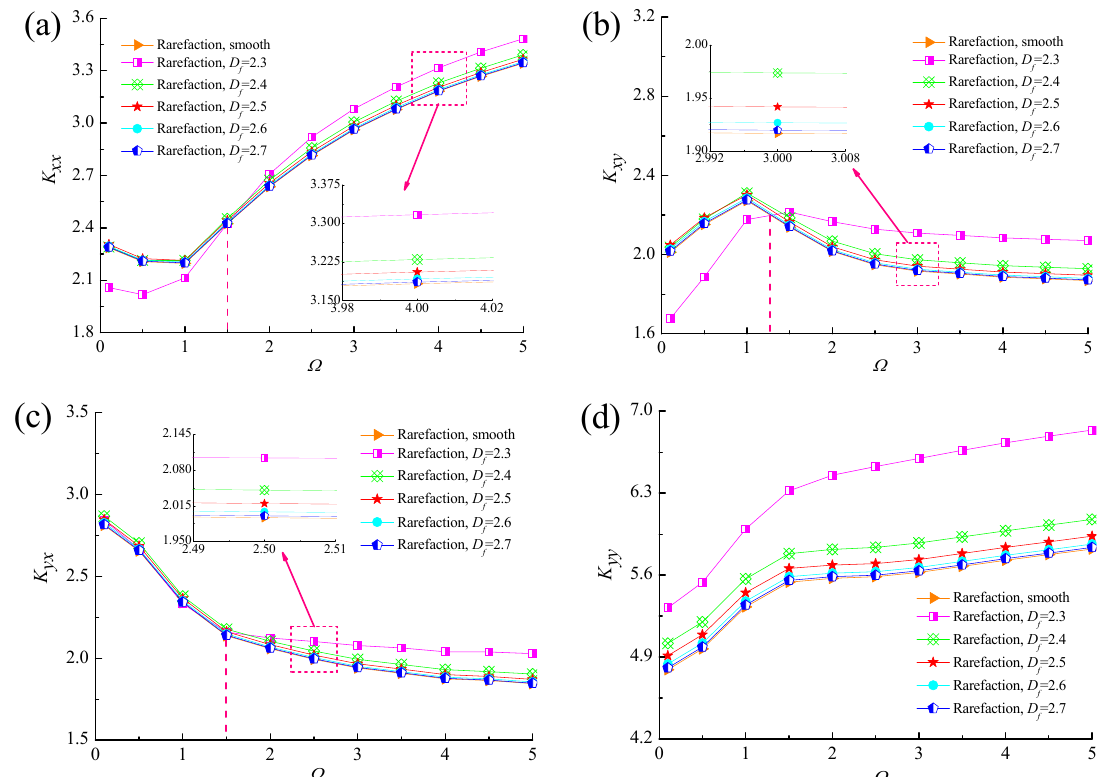
Figure 12. Effect of perturbation frequency on dynamic stiffness coefficients with different fractal dimensions. ( a ) K xx vs. Ω ; ( b ) K xy vs. Ω ; ( c ) K yx vs. Ω ; ( d ) K yy vs. Ω.